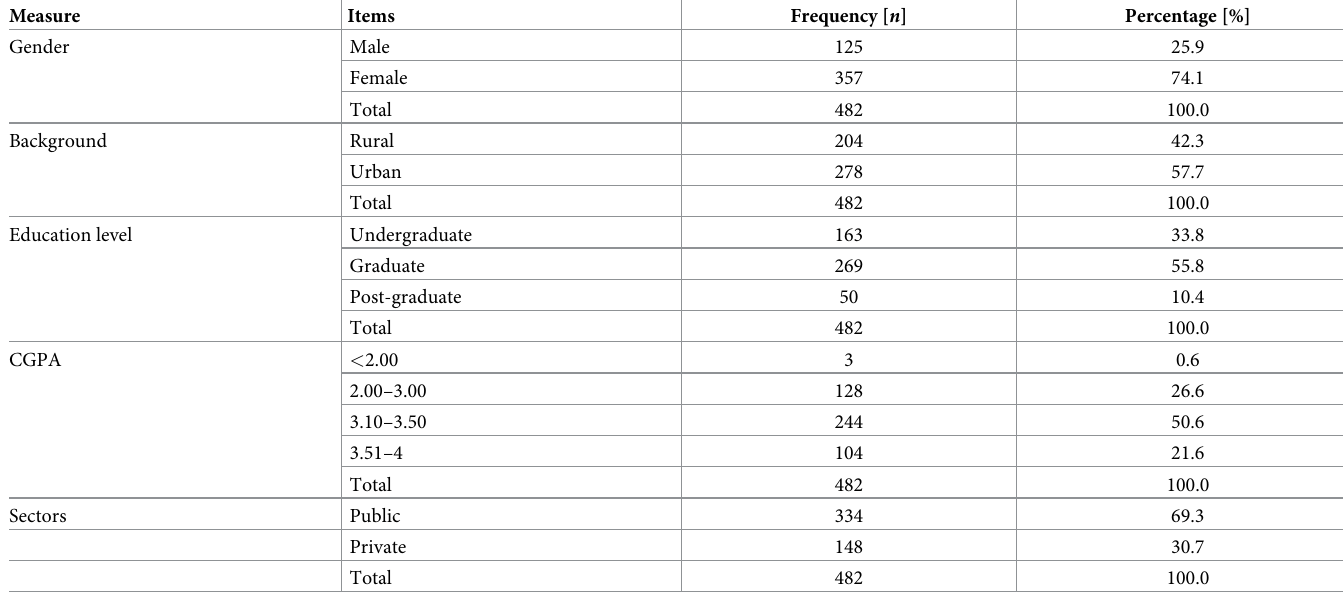
Table 1. Demographic characteristics of